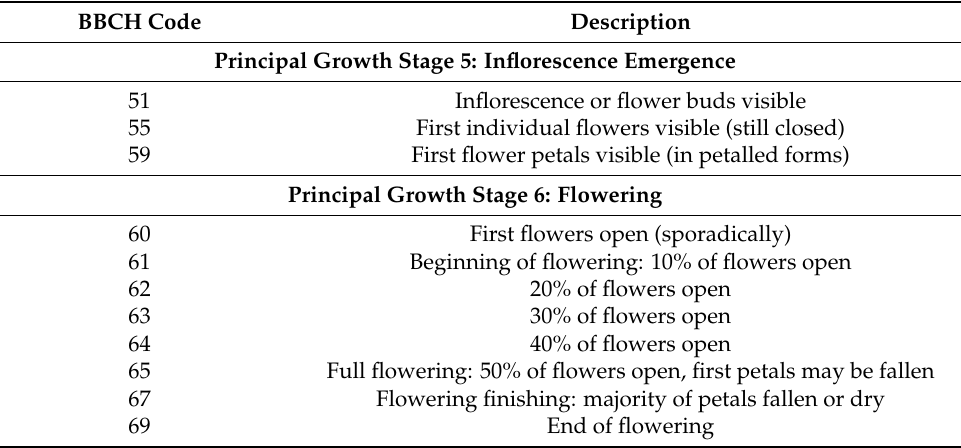
Table 1. Black locust BBCH scale used in the Italian Phenological Network—IPHEN, adapted from Meier, 2018